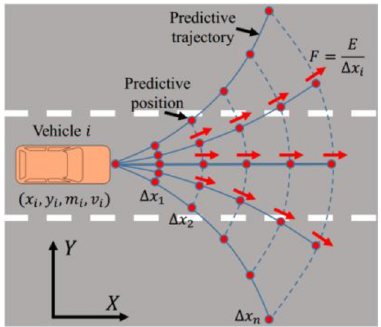
Figure 6 Predictive trajectories and positions